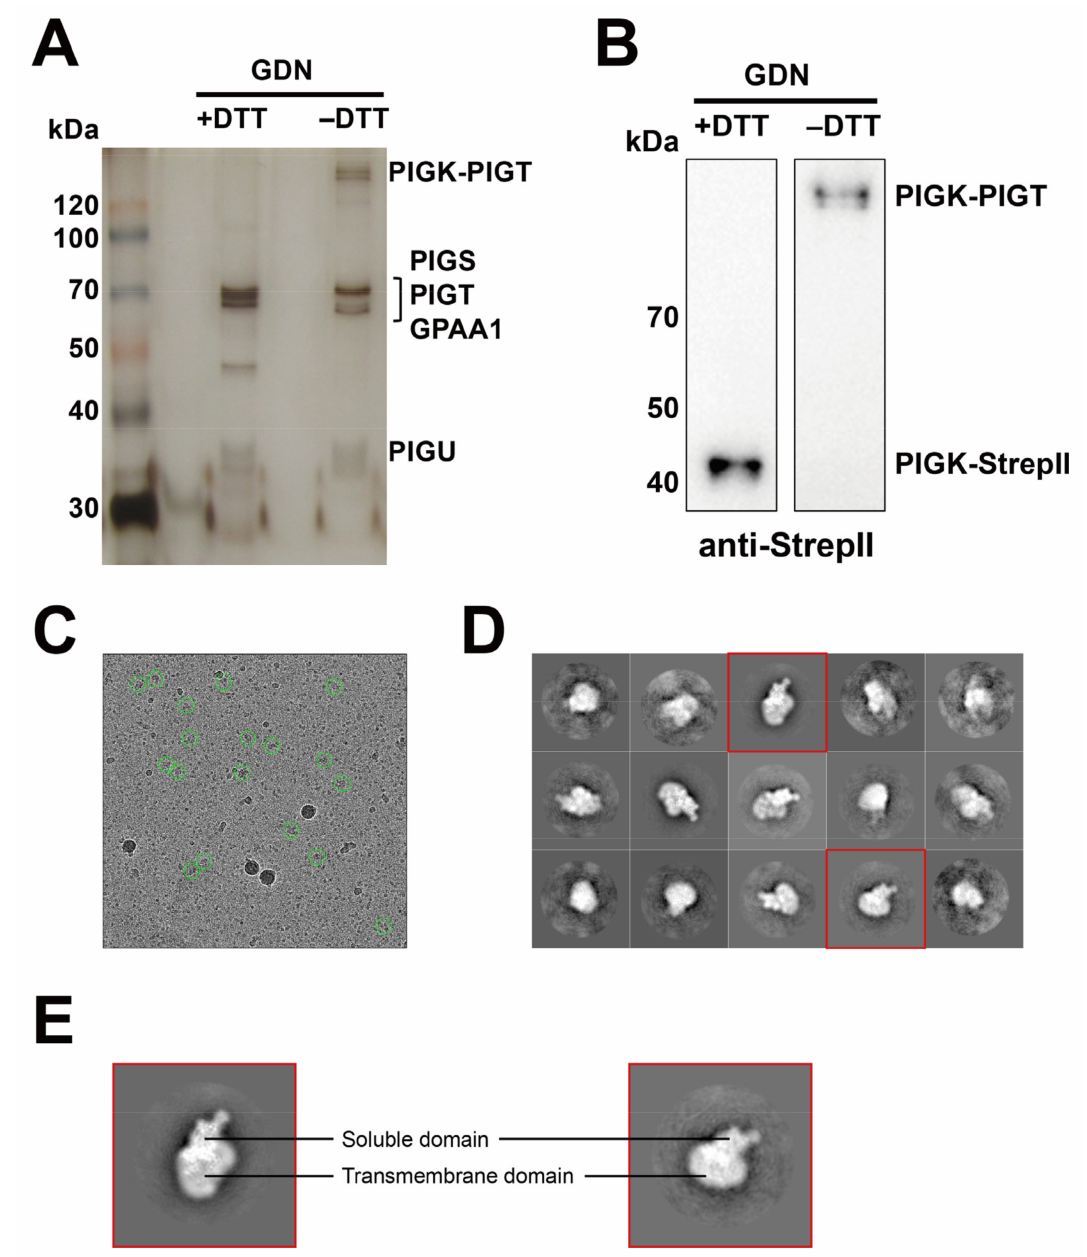
Figure 6. Large-scale purification of the GPI-TA complex by GDN. ( A , B ) PIGK-StrepII containing the GPI-TA complex was purified in buffer containing GDN. The purified samples were detected by silver staining ( A ) or by western blotting ( B ). Samples were detected under reducing (+DTT) or nonreducing ( − DTT) conditions as described in Figure 5. For western blotting, an anti-StrepII antibody was used to detect PIGK-StrepII. ( C ) EM images of the purified PIGK-StrepII containing the GPI-TA complex in GDN, which were obtained using a 300 kV cryo-EM equipped with a K2 summit direct electron detector camera. ( D ) Representative 2D classification of cryo-EM data showing different orientations of the protein, with the box size of 390 angstrom and the mask of 300 angstrom processed on RELION. Red square, selected images used in ( E ). ( E ) Particle features observed from the 2D classes. Putative soluble domain and transmembrane domain are indicated,